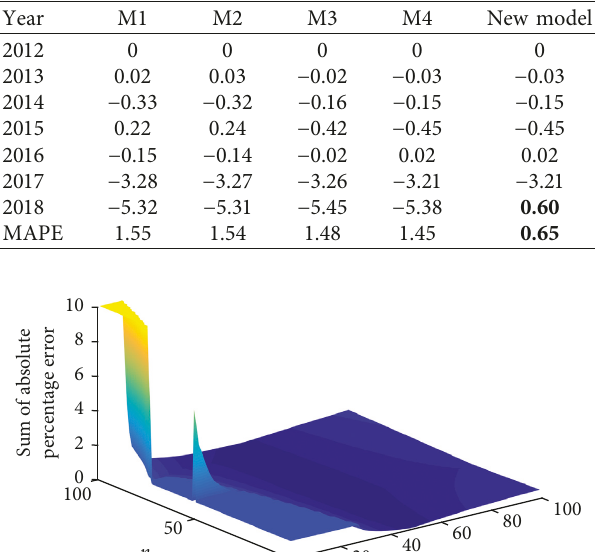
Table 7: Relative error values of China’s GDP data by the five grey models (%).